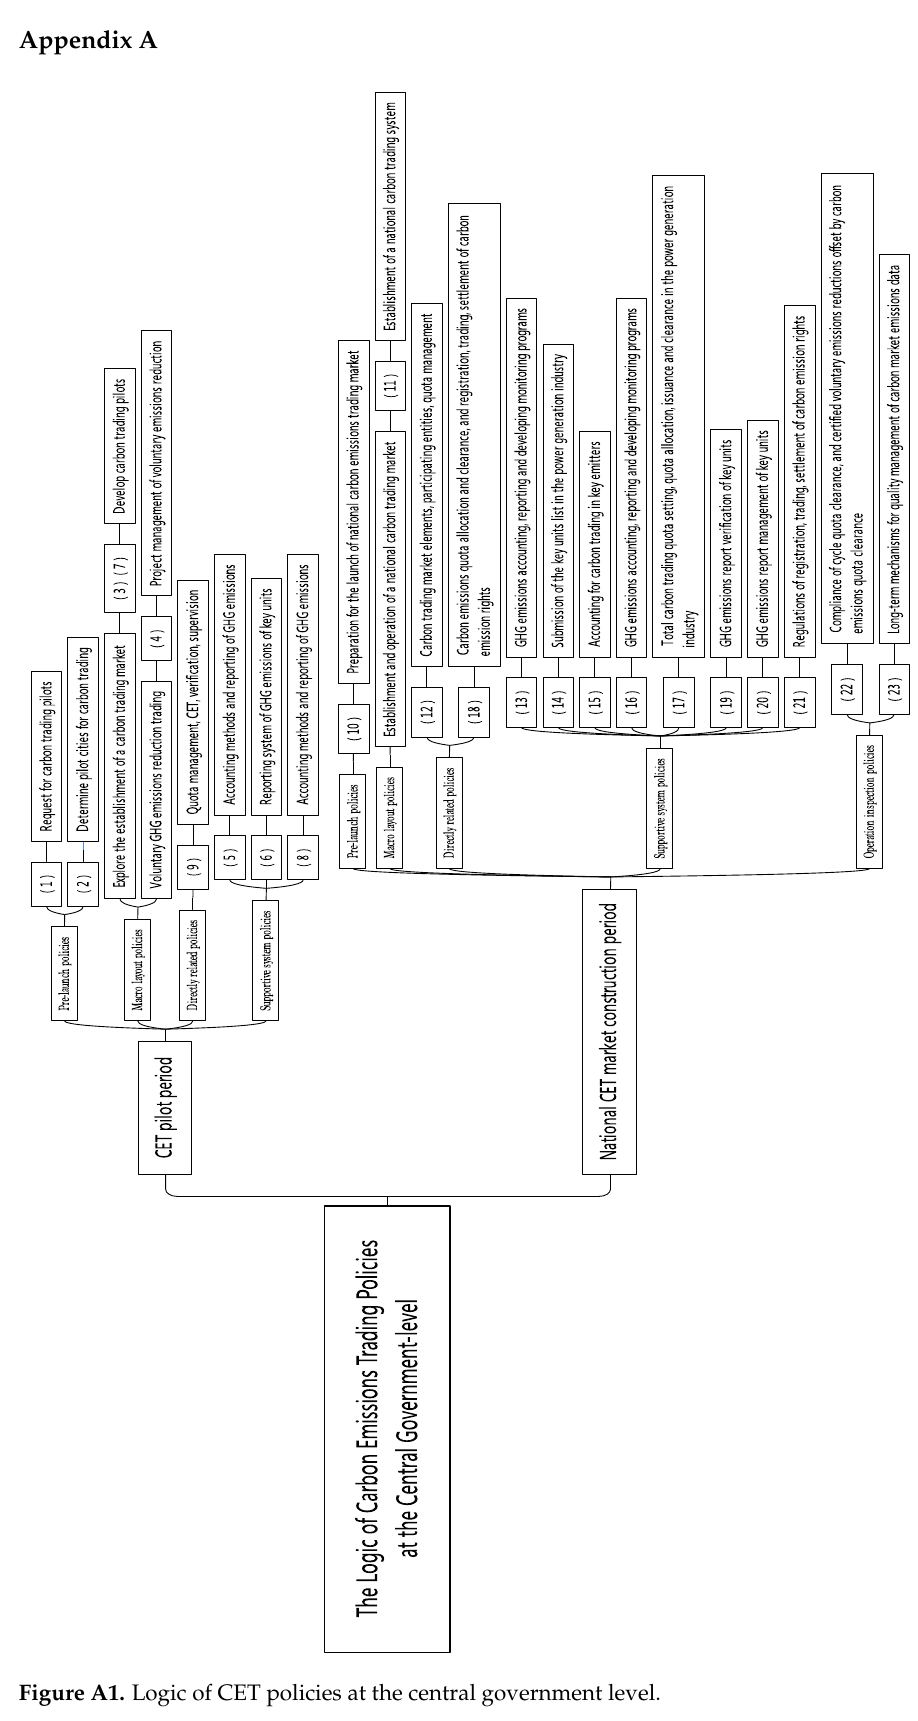
Figure A1. Logic of CET policies at the central government level.